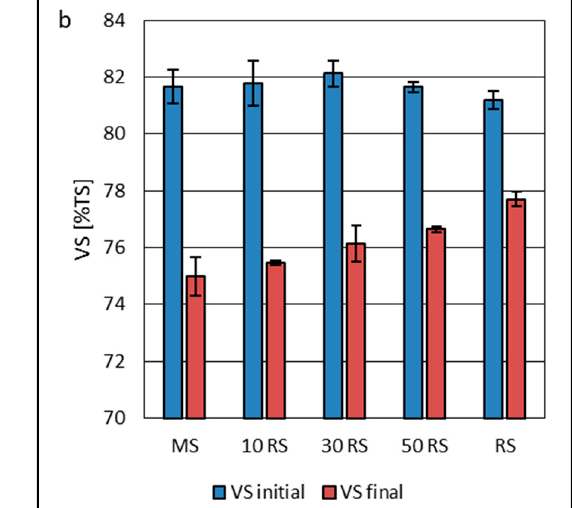
4:1 * Lowercase letters—statistical differences at p < 0.05 among silages and inoculum.